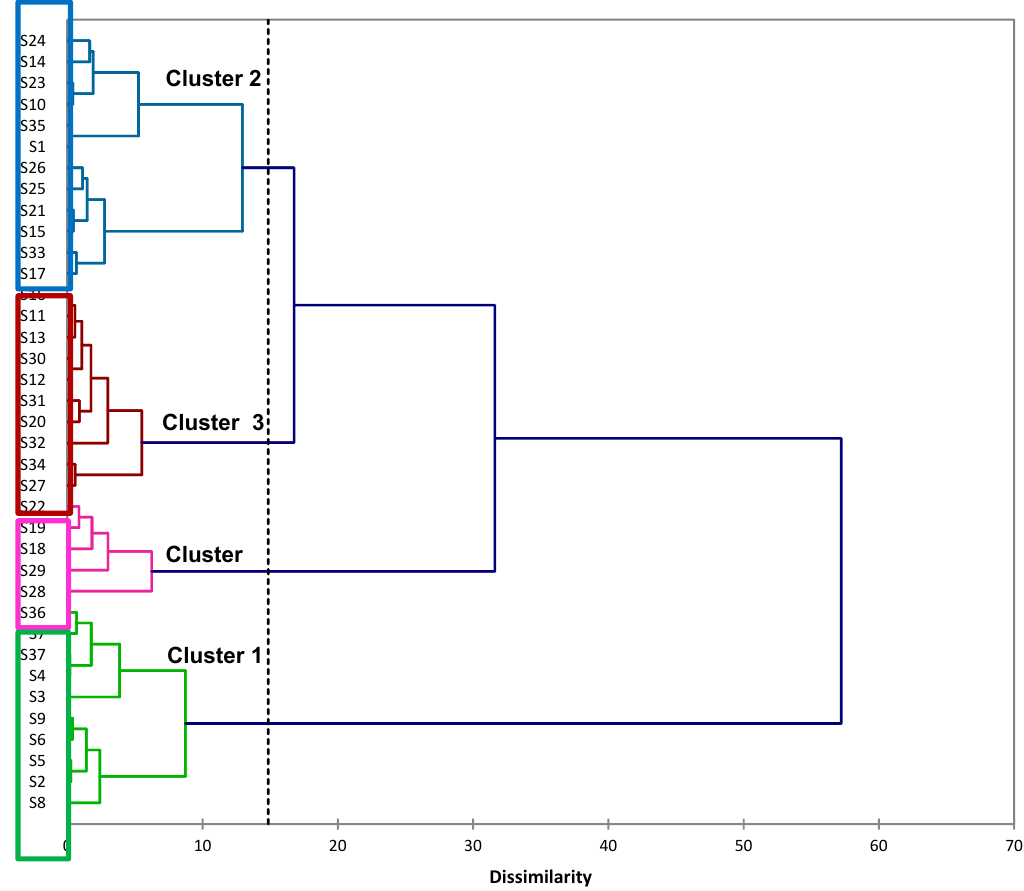
Figure 2. Hierarchical clustering of fungi species using Ward's method and XLSTAT (Addinsoft).